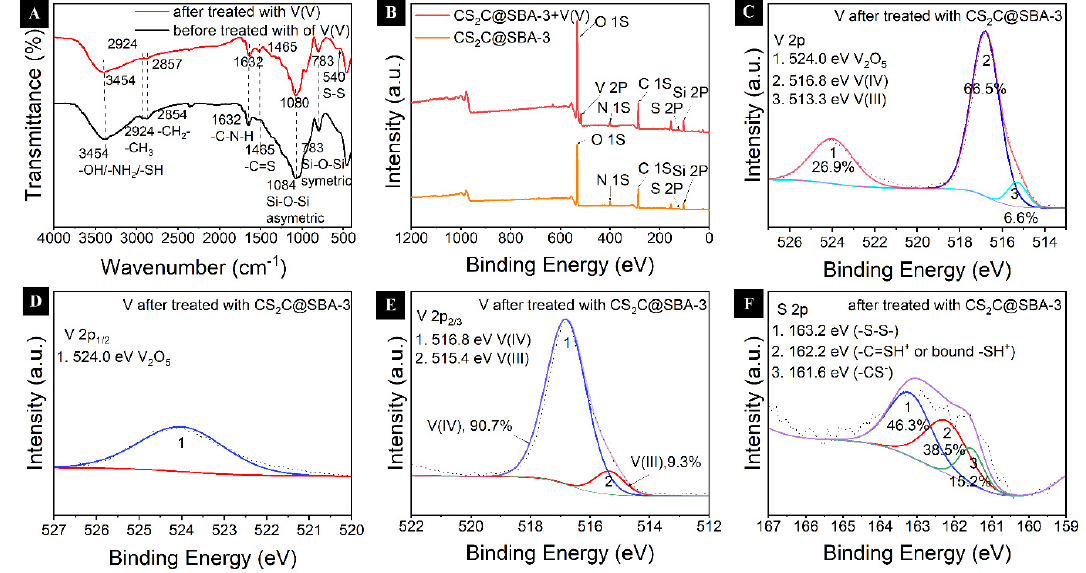
Figure 9. FTIR spectra of CS 2 C@SBA − 3 before and after adsorption ( A ). The XPS survey spectra of CS 2 C@SBA − 3 before and after adsorption ( B ). V 2p ( C ), V 2p 1/2 ( D ), and V 2p 2/3 ( E ). The XPS high − resolution of S 2p ( F ).